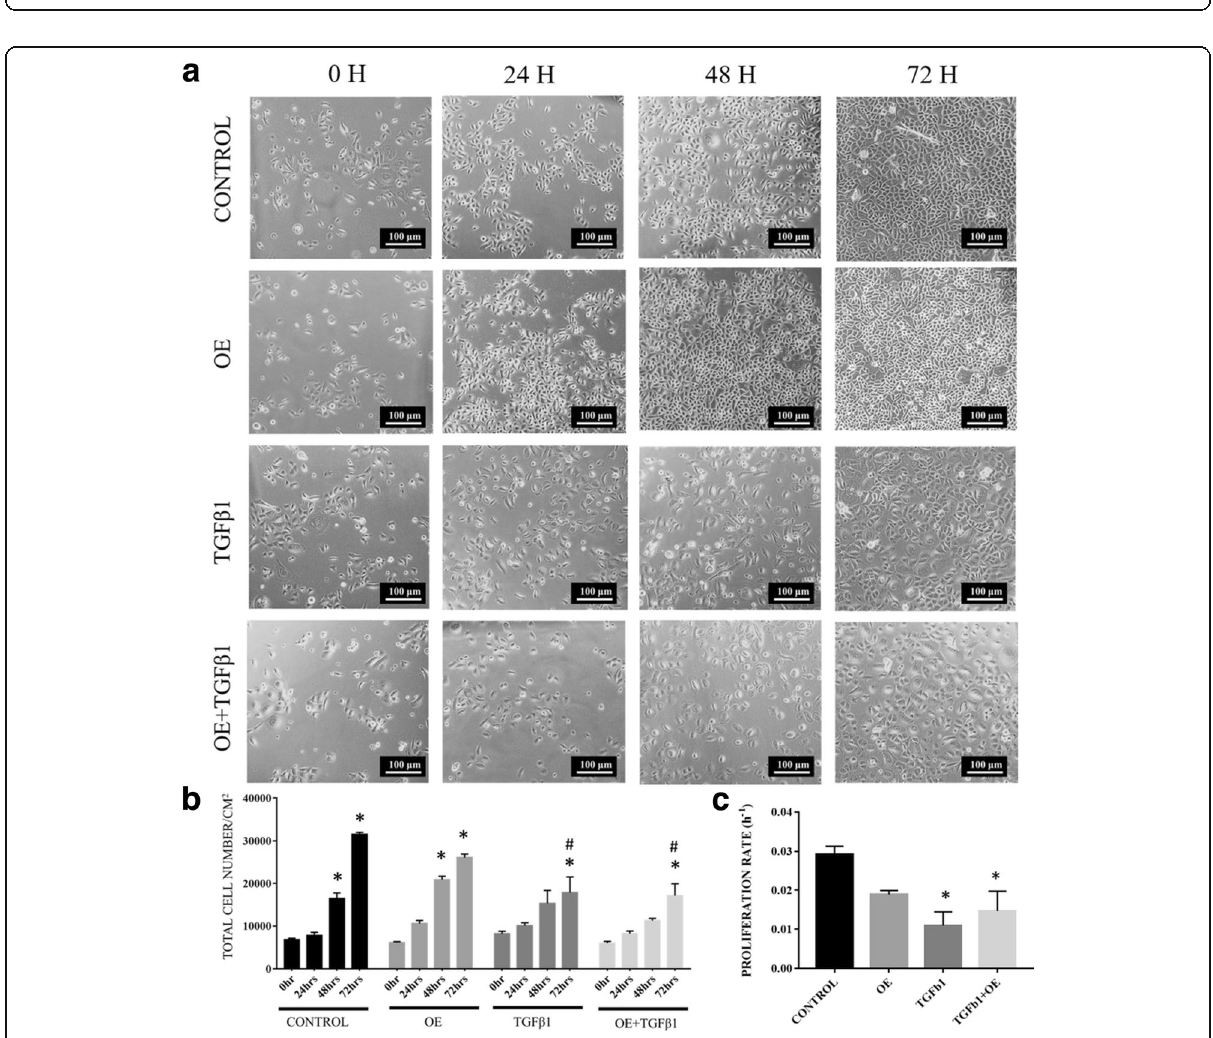
Fig. 4 a Distribution of untreated RECs (control), 0.05% ( v /v) OE-treated RECs (OE), RECs induced to EMT with 5 ng/ml TGF β 1 (TGF β 1) and RECs induced to EMT with TGF β 1 and treated with OE (TGF β 1 + OE) from 0 h to 72 h. b Total cell number/cm 2 versus (vs) time per group. * P < 0.05 indicates significant difference when compared with 0 h and # P <0.05 indicates significant difference when compared with the control group. c The proliferation rate of cells. * P <0.05 indicates significant difference when compared with the